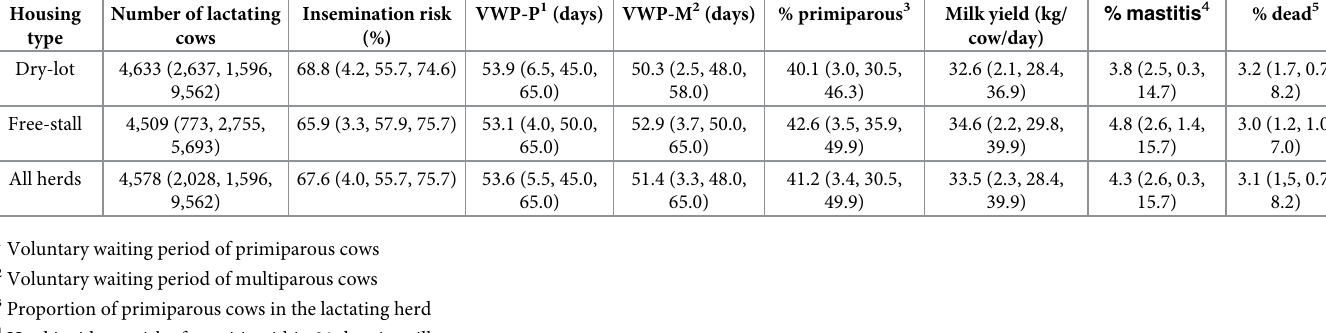
Table 1. Descriptive data for the nine large Kansas dairy herds enrolled in this study. Data are presented as mean (SD, minimum, maximum). Housing